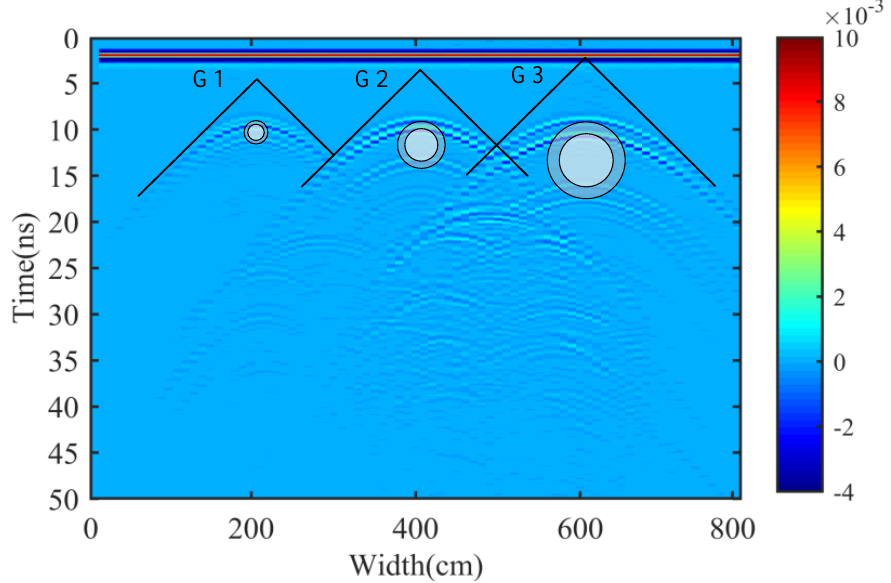
diameters of 0.3 m, 0.6 m, and 1.0 m, respectively. Reflected waves are evident at the top reflected waves are. There are multiple reflected and stray waves at the bottom of the profile image. In Figure 15, the PVC plastic pipe on the right side of the profile has weak reflected waves, and the concrete pipeline located on the left side has distinct hyperbolic reflected waves. The reflected waves are evident at the top of the middle metal tube, while not at the bottom. In addition, some interfering stray waves and multiple reflected waves can be observed at the bottom of the image.